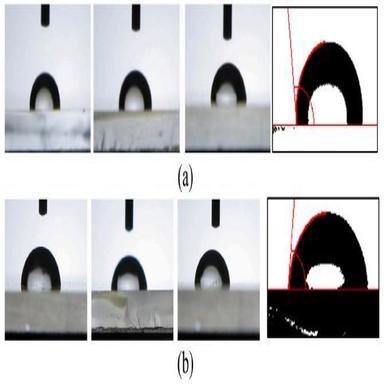
DI-water-droplet images captured for three regions, along with CA measurements: (a) untreated and (b) annealed films.